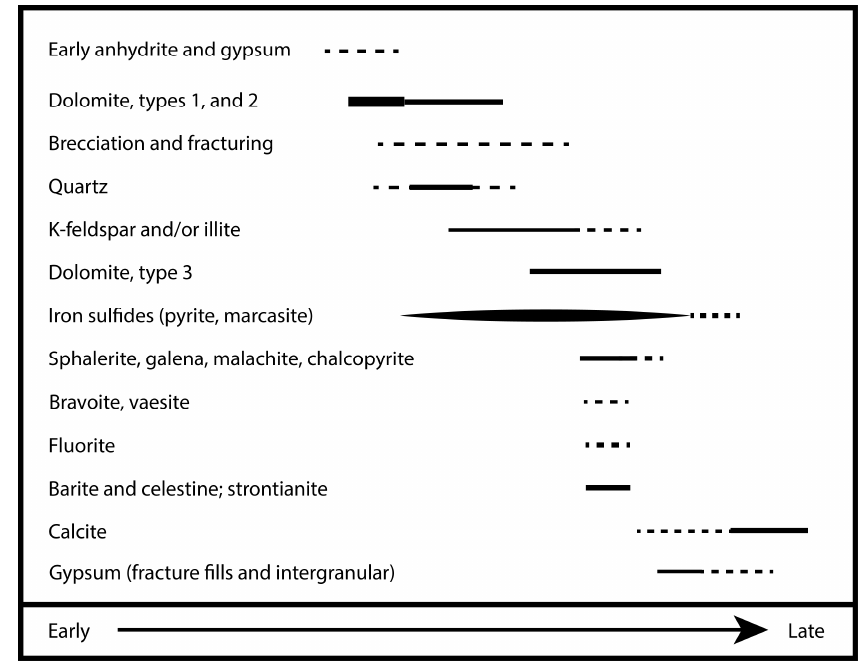
Figure 12. Generalized paragenetic sequence for Paleozoic rocks in northeastern Wisconsin.